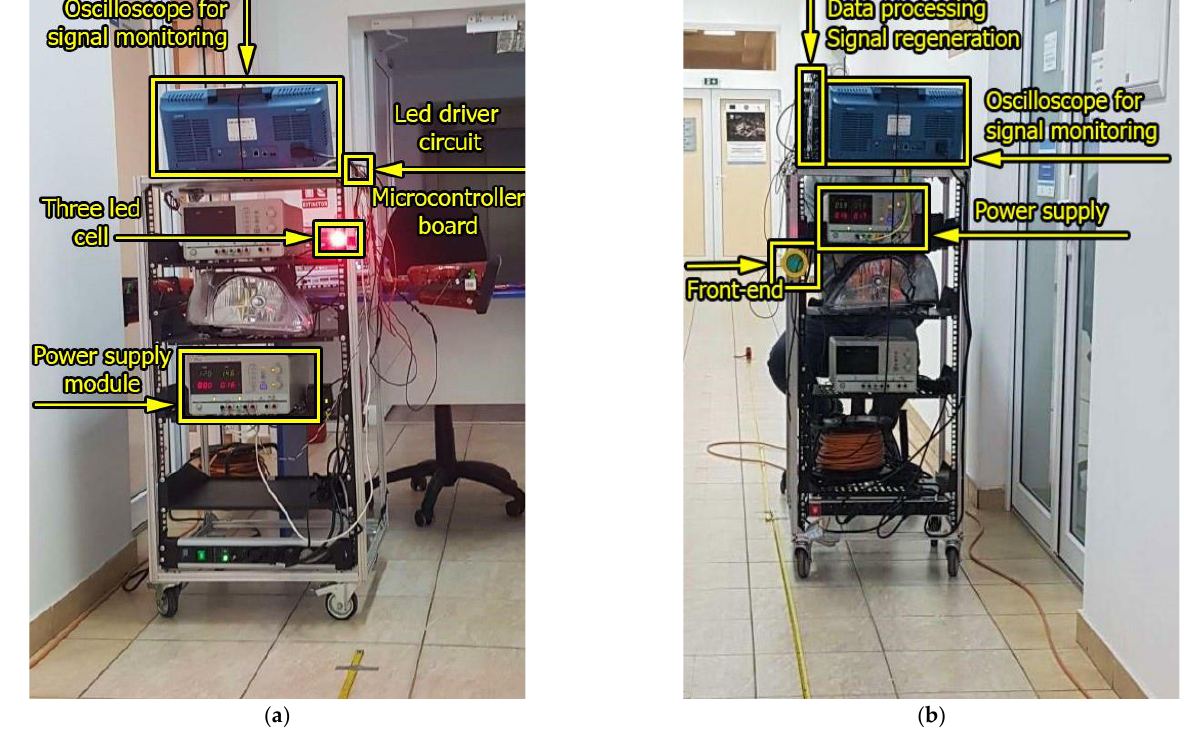
Figure 6. Hardware implementation of the VLC prototype used for the range extension experiments: ( a ) VLC emitter; ( b ) VLC receiver. Table 2. Parameters of the VLC emitter test